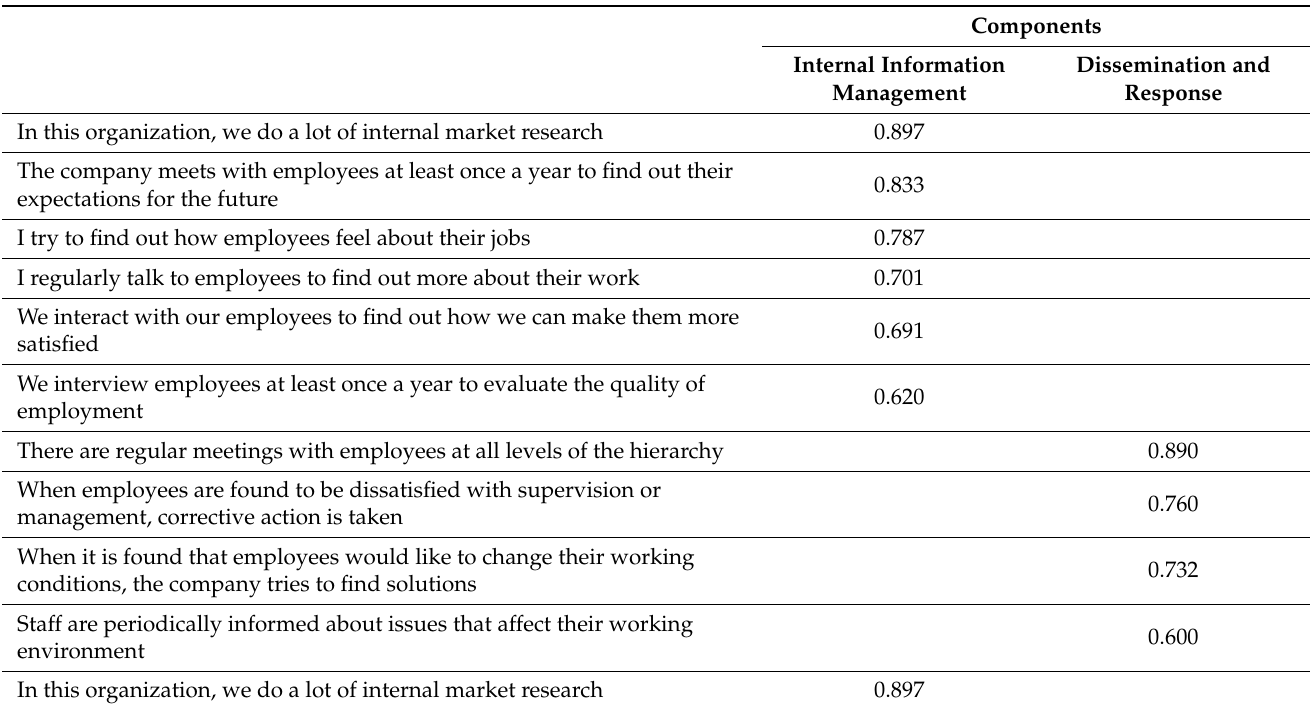
Table 14. Component matrix after varimax rotation.